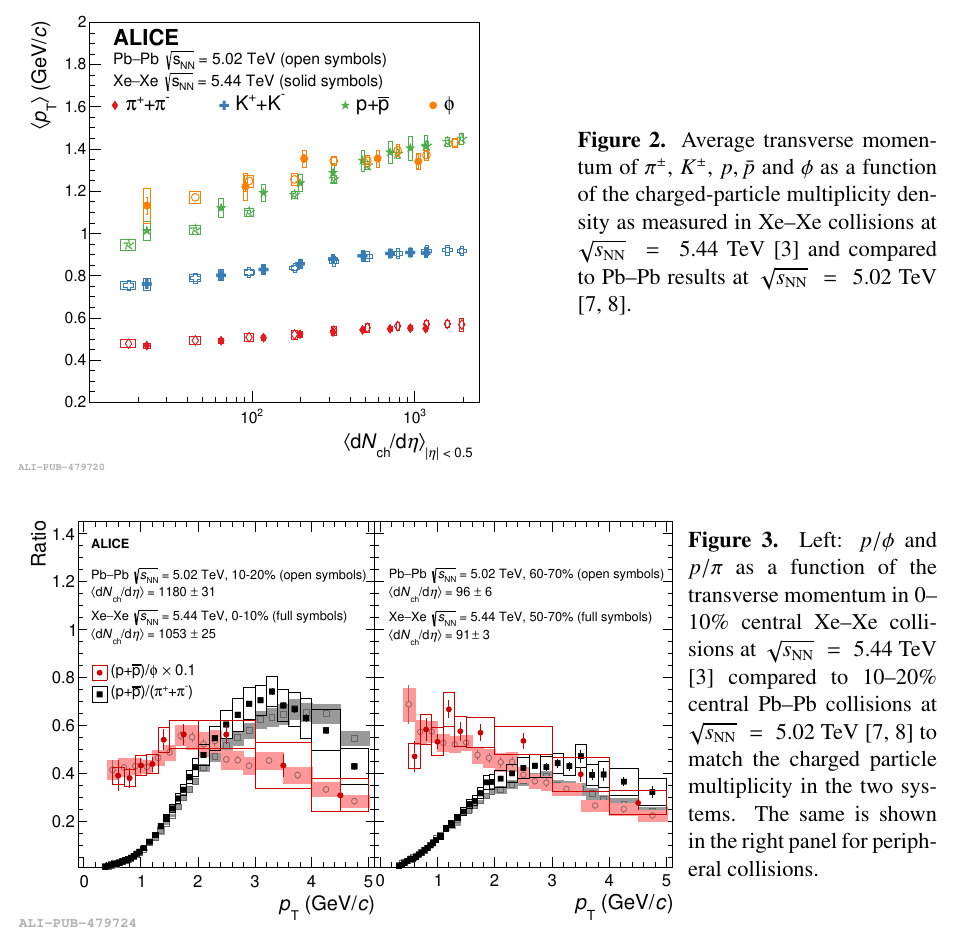
Figure 2. Average transverse momen- tum of π ± , K ± , p , ¯ p and φ as a function of the charged-particle multiplicity den- sity as measured in Xe–Xe collisions at √ s NN = 5 . 44 TeV [3] and compared to Pb–Pb results at √ s NN = 5 . 02 TeV [7, 8].